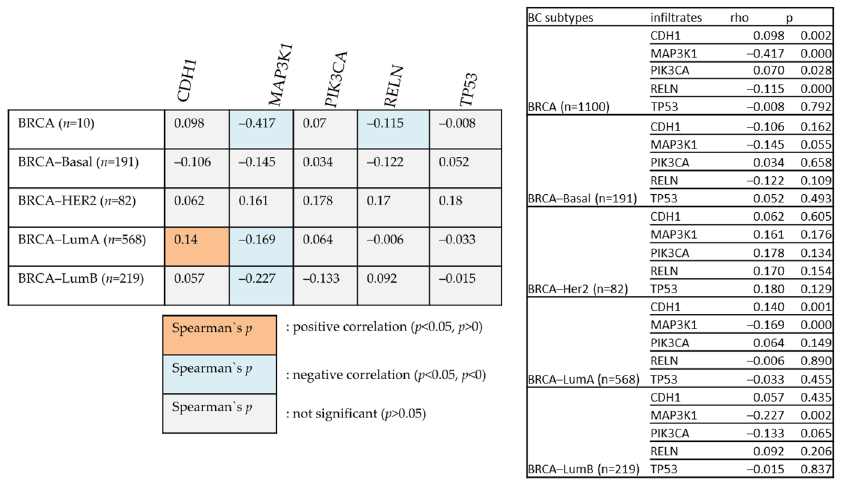
Figure 10. The positive and negative correlation between the mutated genes with BIRC5 in BC subtype patients. Table 1. The most frequently altered genes that significantly changed the expression of BIRC5. The data were accessed on